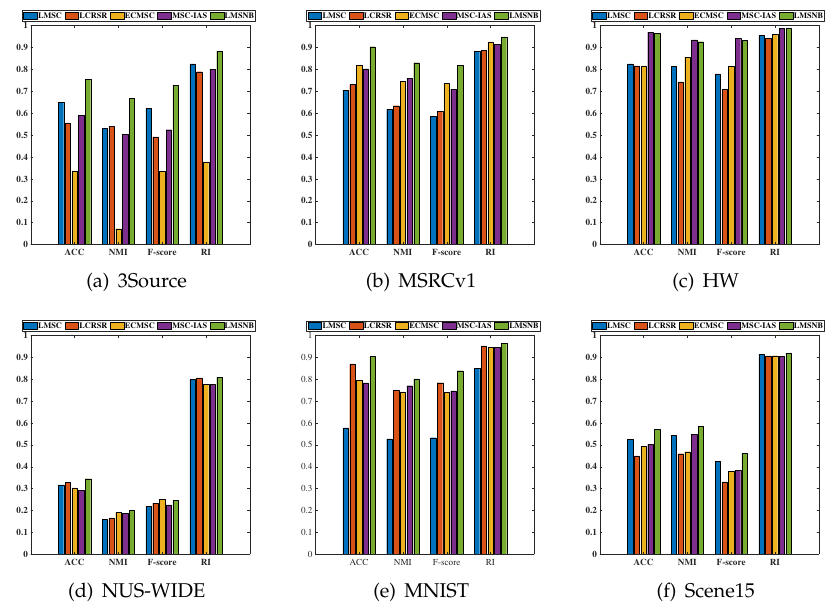
Figure 2. The histograms of clustering performance on different